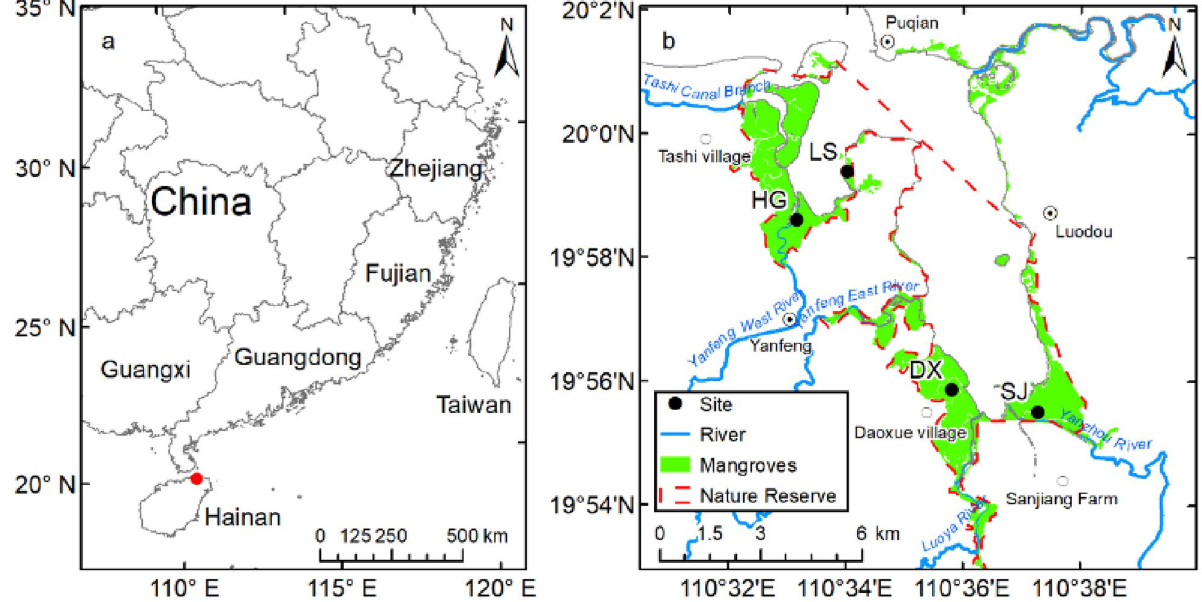
Figure 1. ( a ) Geographical location and ( b ) spatial distribution of mangroves around Dongzhaigang, Haikou City, Hainan Province, China. LS, HG, DX, and SJ refer to Linshi Village, Hegang Village, Daoxue Village, and the Sanjiang farm, respectively. (Partial data from: Zhang et al. 21 ). Maps generated in ArcMap v10.0 (https:// www. esri. com/ en- us/